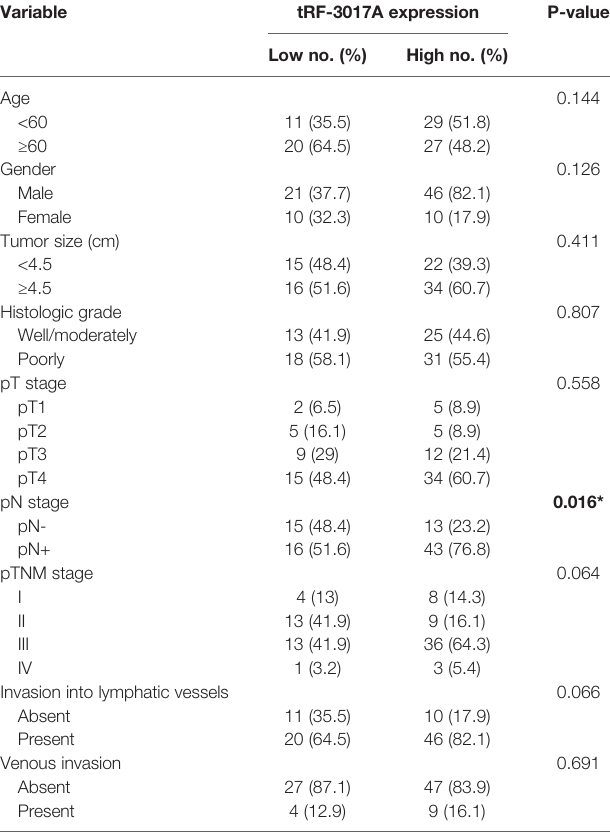
TABLE 1 | Correlation between tRF-3017A expression and clinicopathological factors in tissue samples of GC patients (n = 87). Variable